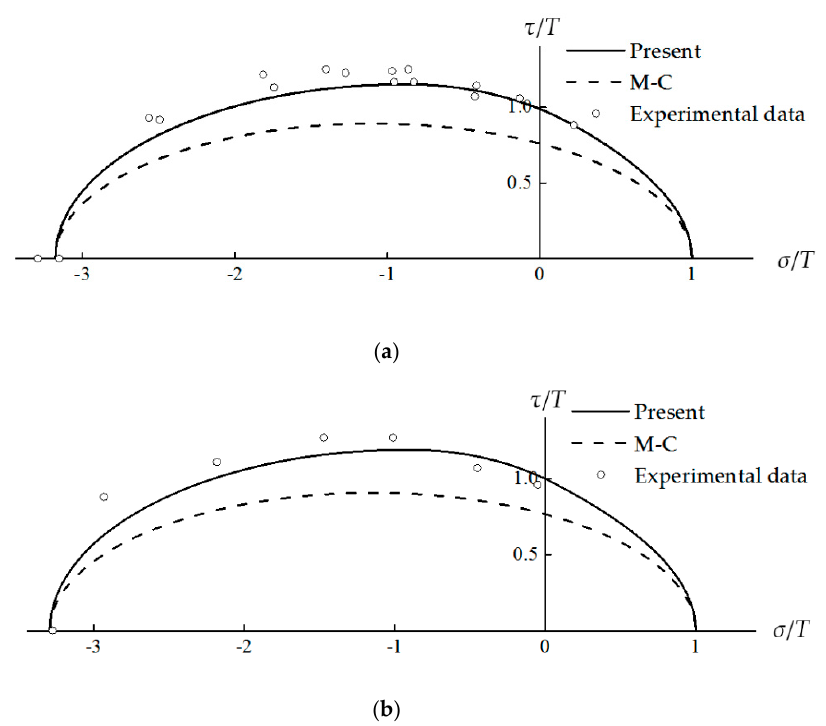
Figure 13. Failure envelopes and the experimental data of cast iron under the combined stress state σ - τ [29,30]. θ T = 90.0°, θ C = 37.0°. ( a ) C / T = 3.18; ( b ) C / T = 3.29.